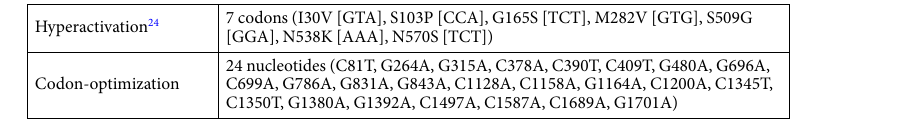
Table 1. Modifications of the coding sequence of the iPBase gene to generate the hyPBase apis